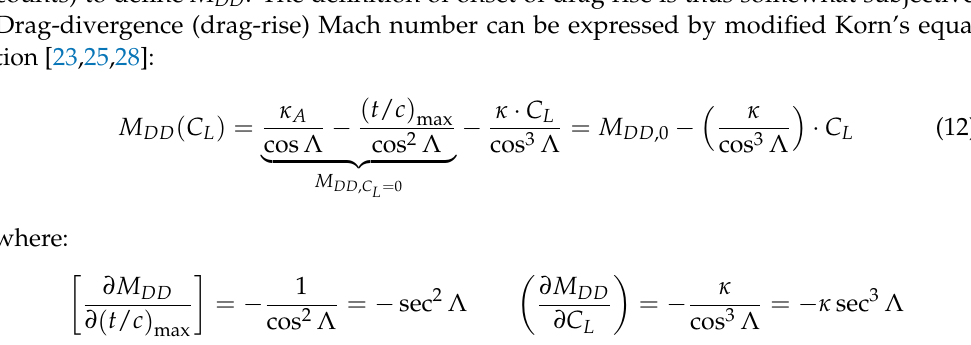
Figure 1. Computed airplane’s total drag coefficient as a function of Mach and coefficient-of-lift. Boeing company traditionally used increase in drag-coefficient of 0.0020 (20 drag counts) to define M DD . The definition of onset of drag rise is thus somewhat subjective.